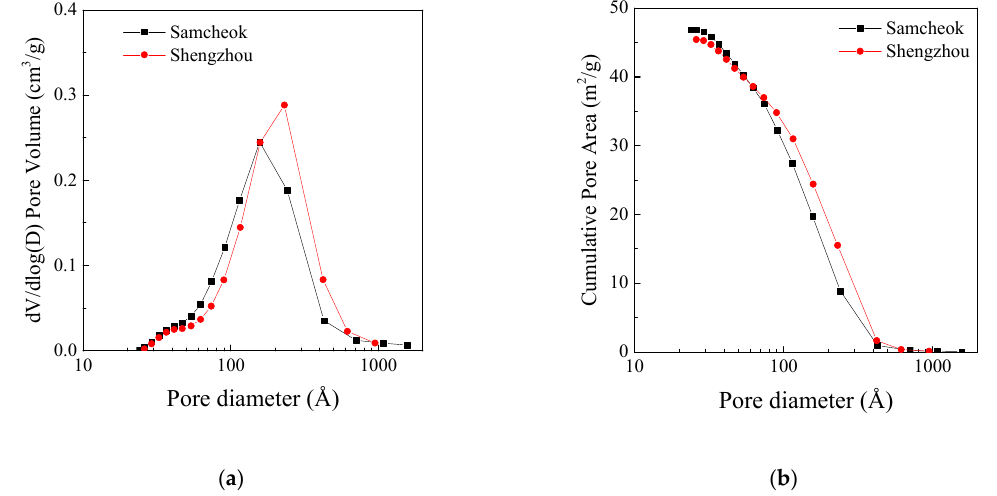
Figure 11. Pore size distribution of CaO after the calcination in the LC-TGA: ( a ) Barrett-Joyner-Halenda (BJH) adsorption dV/dlog(D) (V is the pore volume, and D is the pore size) pore volume; ( b ) BJH adsorption cumulative pore area.